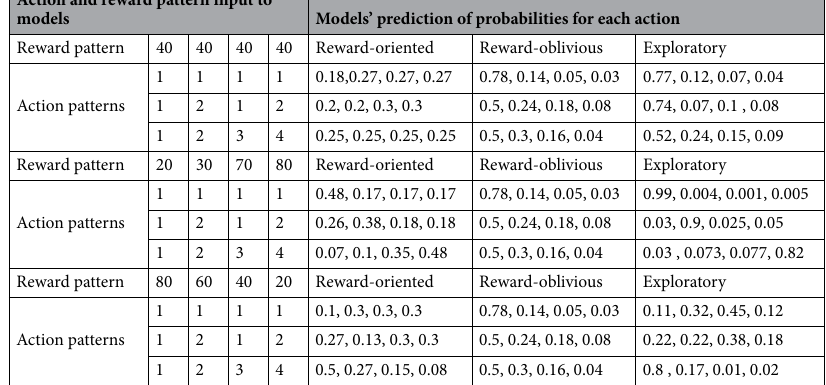
Table 1. Comparison of the reward-oriented vs reward-oblivious models’ predictions on action-reward examples. The predictions are represented as four probabilities for choices, one for each action. Reward- oriented model predicts the highest probability for the action that maximises the expected reward, while the reward-oblivious model predicts the highest probability for the action that completes the pattern that exists in the sequence of previous actions. Identifying the conditions under which the Exploratory model’s predictions converge with the reward-oriented model’s, and those in which it converges with the reward-oblivious model’s, can be used to characterise and explain the Exploratory